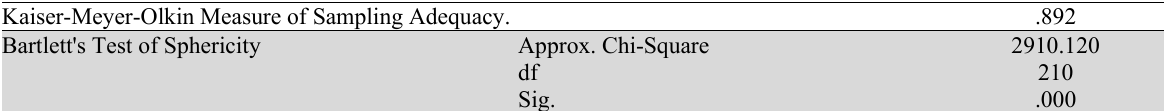
The result of Cronbach’s alpha scale Scale BEL - Belief in self-capacity, α = 0.826 BEL1